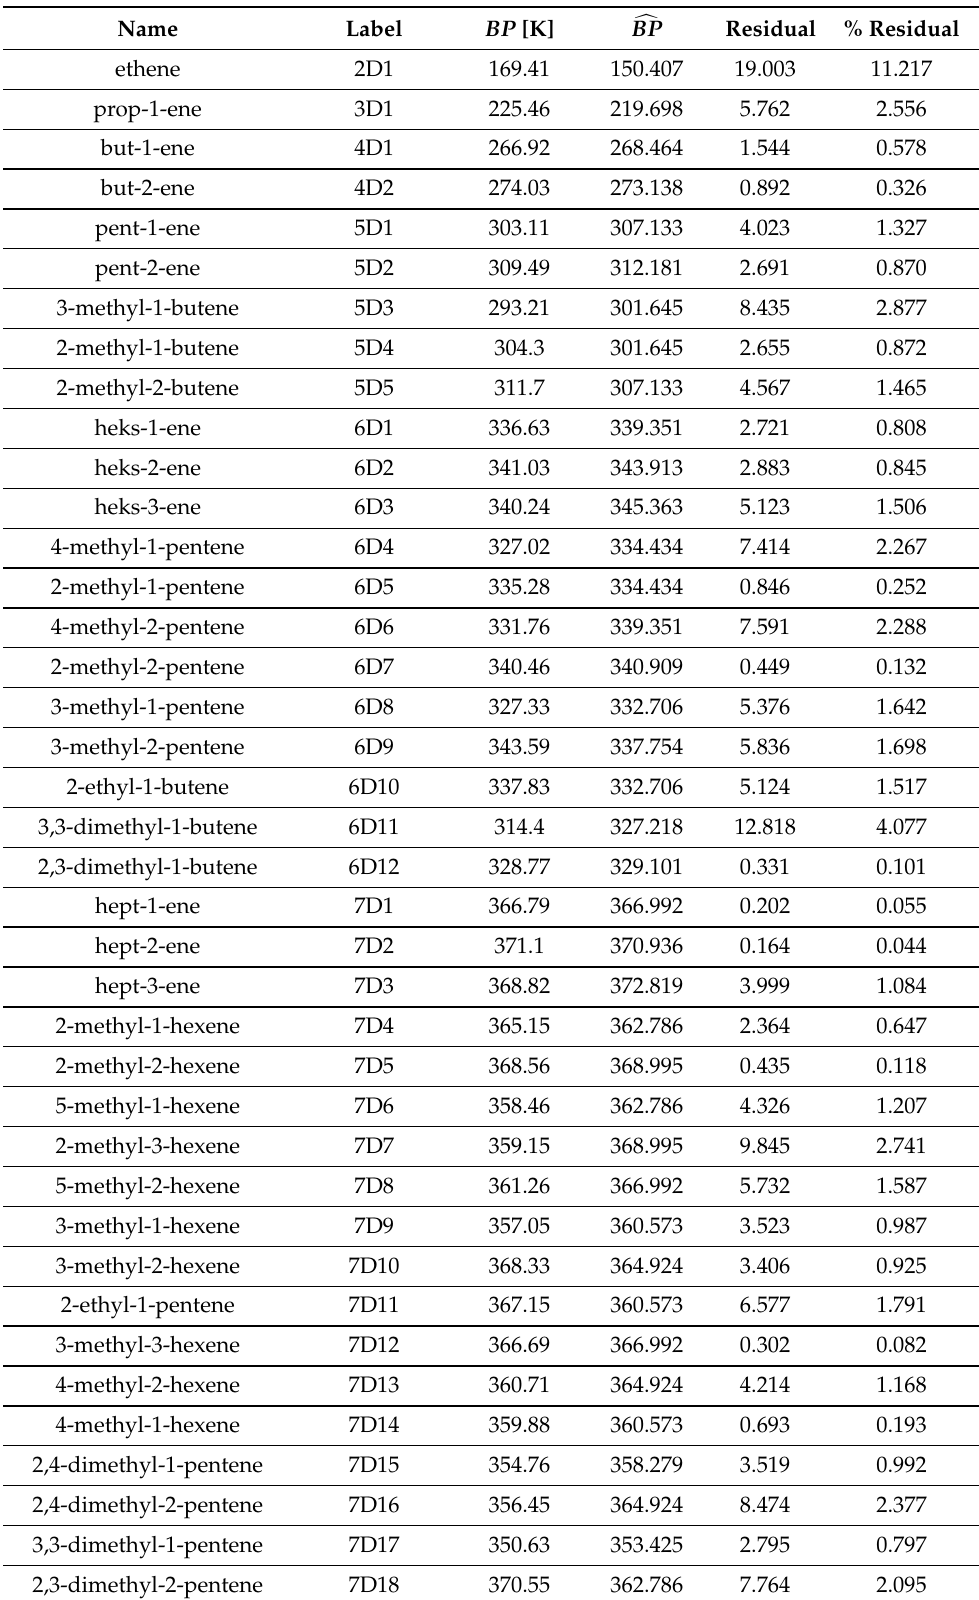
Table 5. Data for all considered